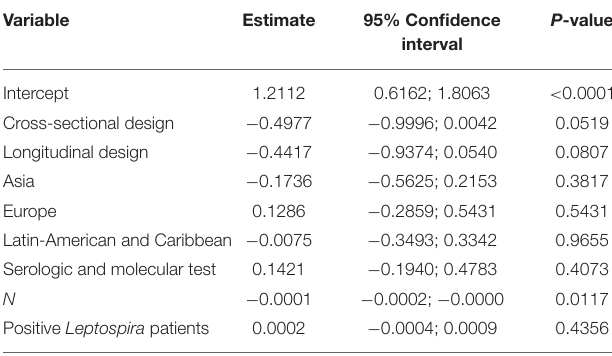
TABLE 5 | Summary of metaregression analysis outputs for the variables that influenced the proportion of fever and two more symptoms at suspicious patients of leptospirosis.